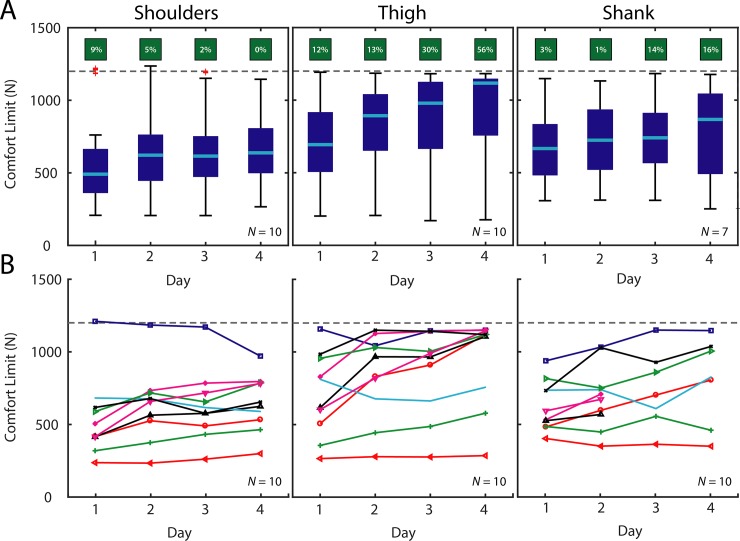
Inter-Day comfort limits.A) Group results. Boxplots depict group results for each testing day. Percentage of trials that reached the maximum approved force limit are depicted in green boxes above each column. B) Subject-specific results. Each marker (colored shape) depicts the median comfort limit for a single subject across multiple days. The 1200 N maximum approved force limit is denoted with a dashed gray line.